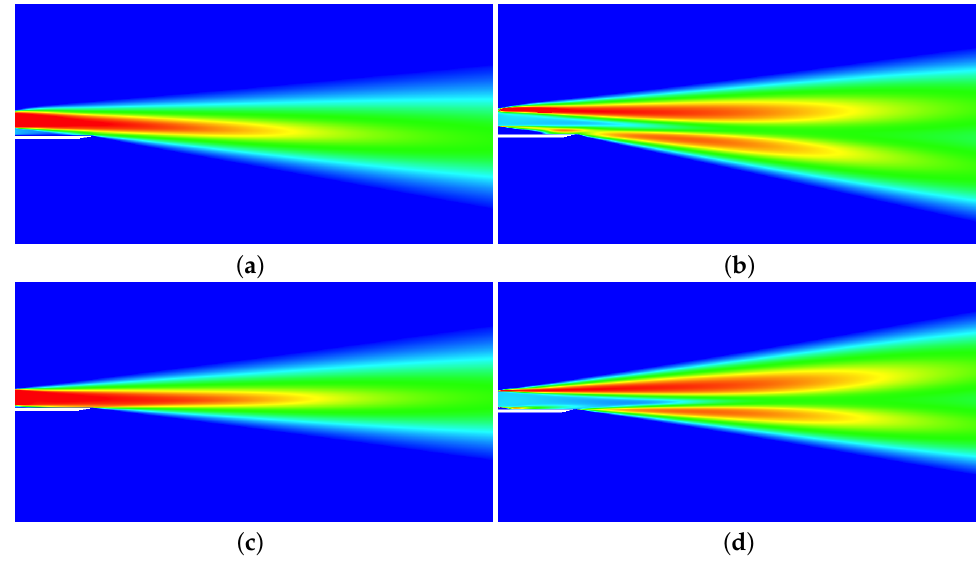
Figure 2. Mean velocity magnitude ( left ) and turbulent kinetic energy ( right ) distributions from RANS simulations of two cases. Top ( a , b ): d = 1.0 D j , L = 5 D j ; Bottom ( c , d ): d = 0.65 D j , L = 5 D j .